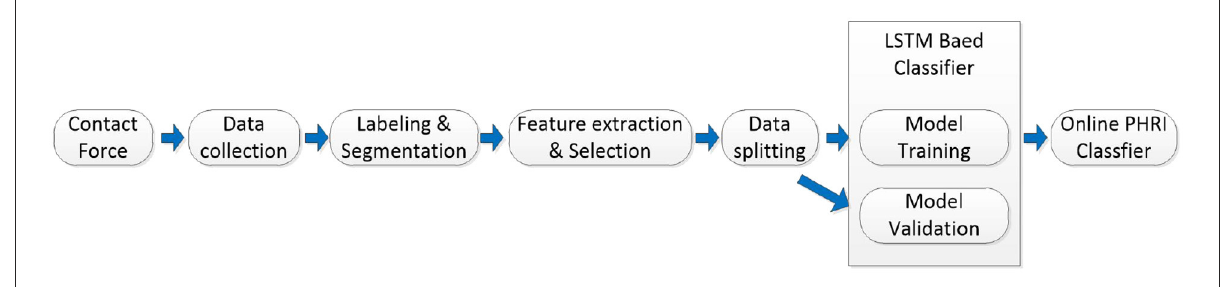
FIGURE3 Schematic diagram of classification process.